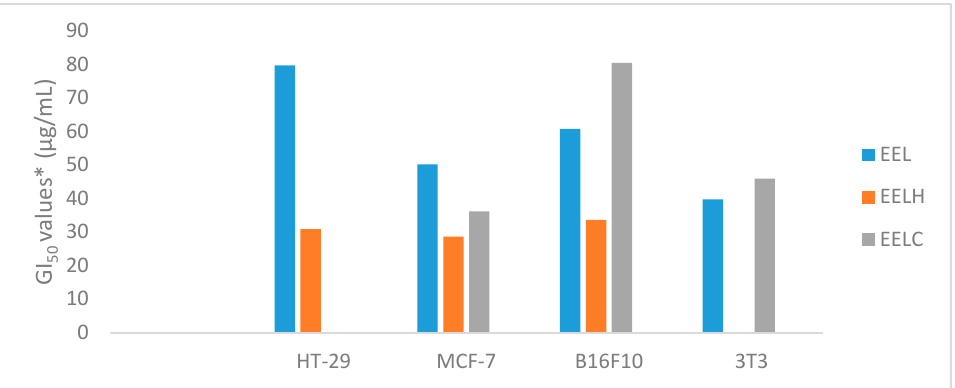
Figure 5. Cytotoxic activity, GI 50 values* (µg/mL) for extracts and fractions of leaves of Garcinia gardneriana , HT-29 (colon carcinoma), MCF-7 (breast carcinoma), B16-F10 (murine melanoma), and NIH/3T3 (murine fibroblast)**. *Concentration that inhibits 50% of cell growth determined by nonlinear regression analysis using the software ORIGIN 6.0. **Mean value ± standard deviation, n = 3. EEL ( ethanol leaf extract) , EELH ( hexane fraction ), and EELC ( Chloroform fraction) .